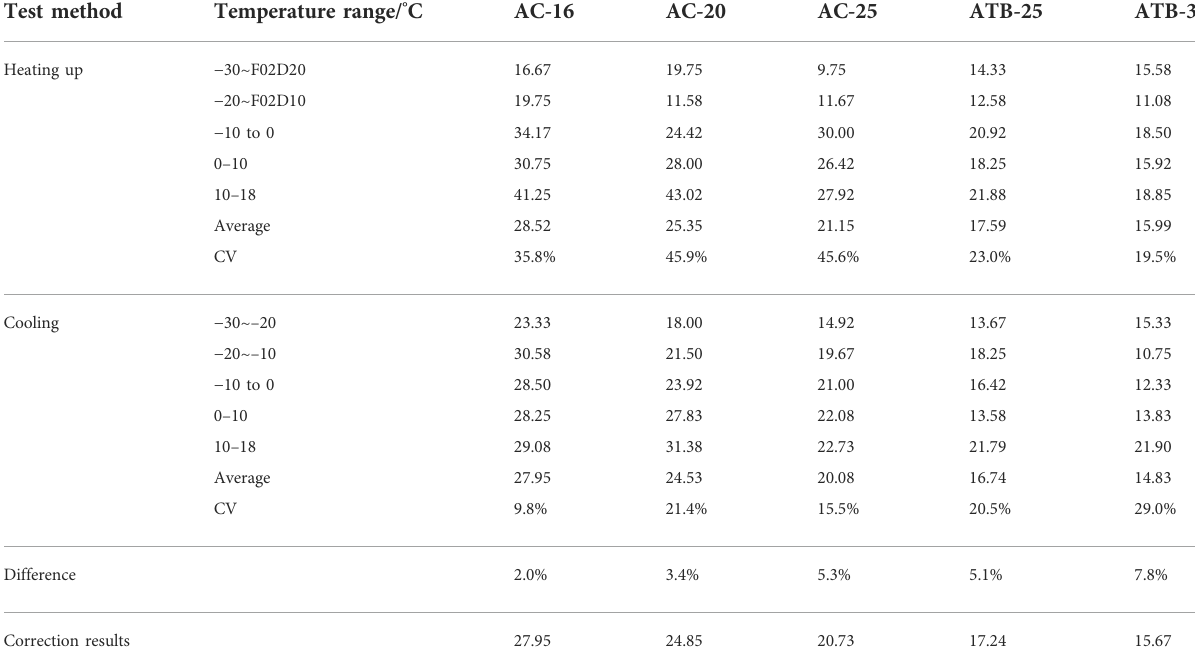
TABLE 3 Temperature shrinkage coef fi cient of the asphalt mixture in different temperature